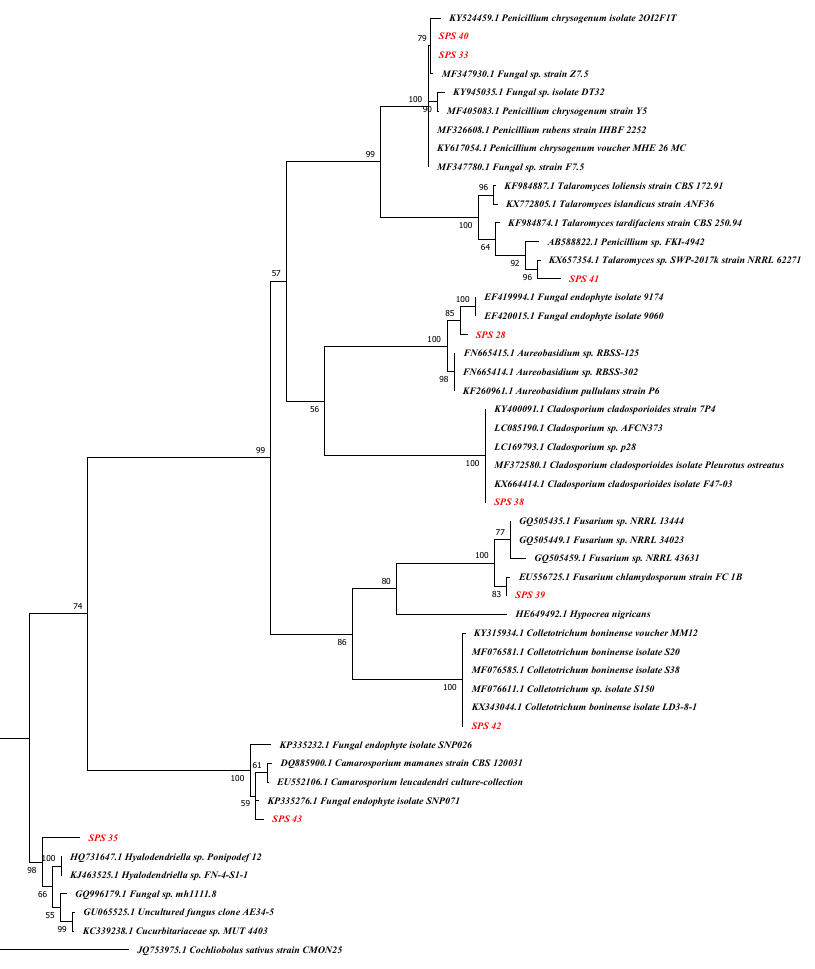
Figure 1. Molecular phylogenetic analysis of ITS1 and ITS4 sequences of all the fungal endophytes isolated from Solanum mauritianum alone, with the sequences from NCBI. The analysis was conducted with MEGA 7 using the Maximum Likelihood method.